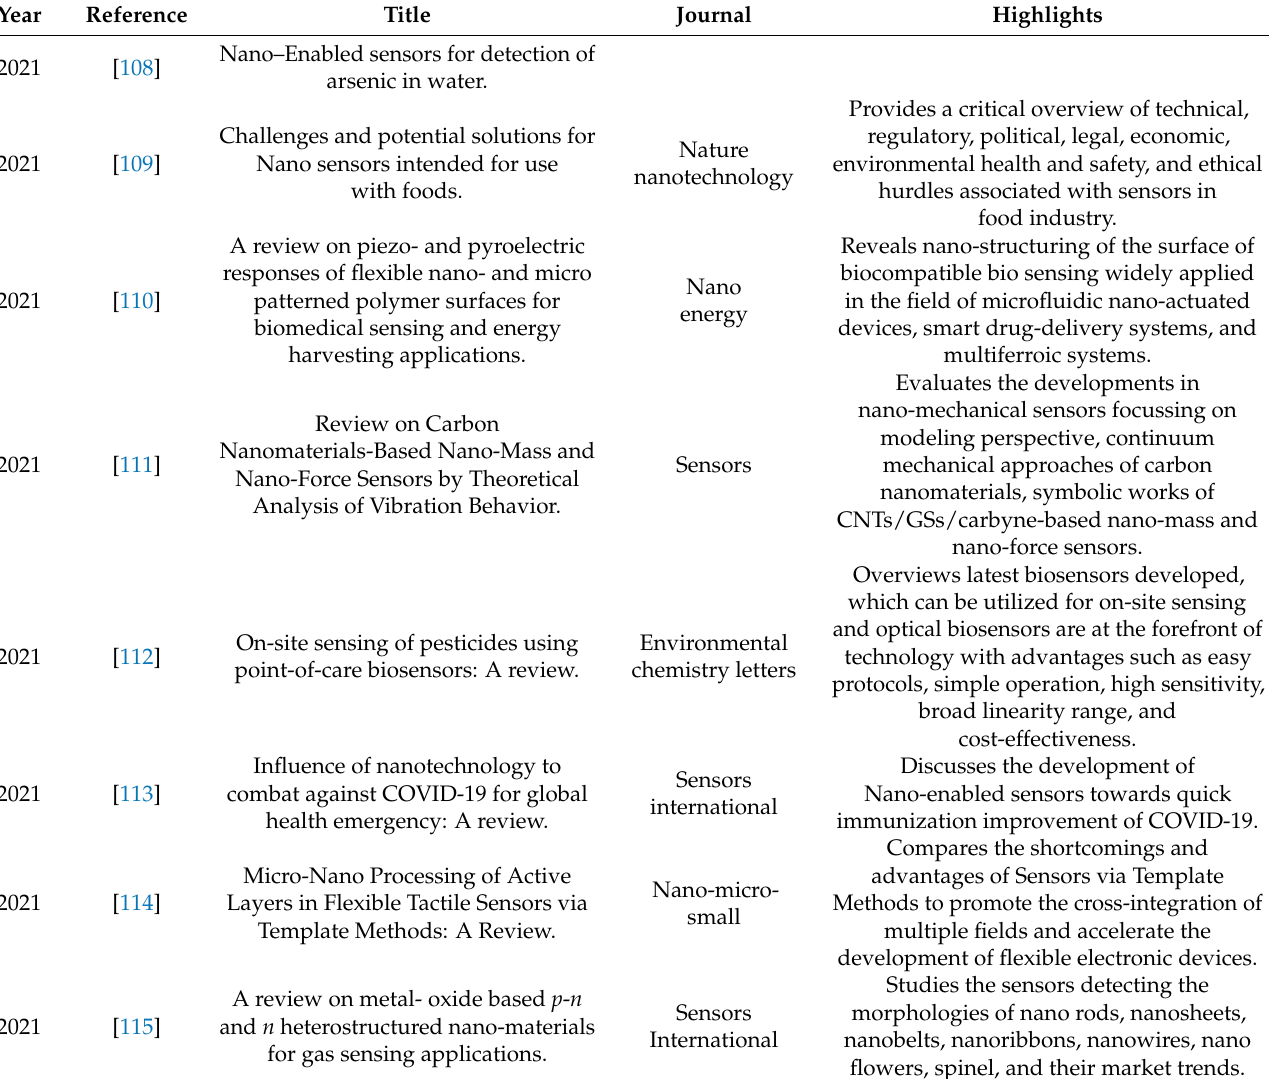
Table 1. A summary of reviews on nano-enabled sensors published in the recent